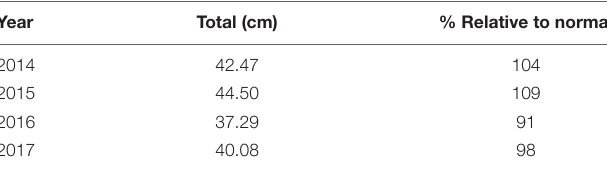
TABLE 3 | Precipitation at the common garden site located at the Colorado State Forest Nursery over the length of the experiment, and the percent precipitation relative to the normal amount (40.8